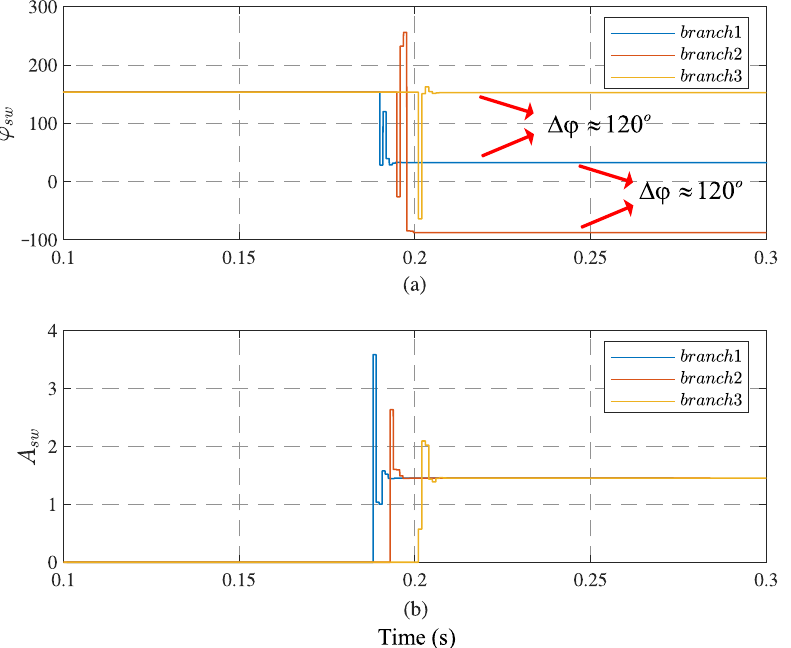
Figure 5. The trends of ϕ sw and A sw of the output voltage when different OCFs occur: ( a ) phase angle change, and ( b ) amplitude